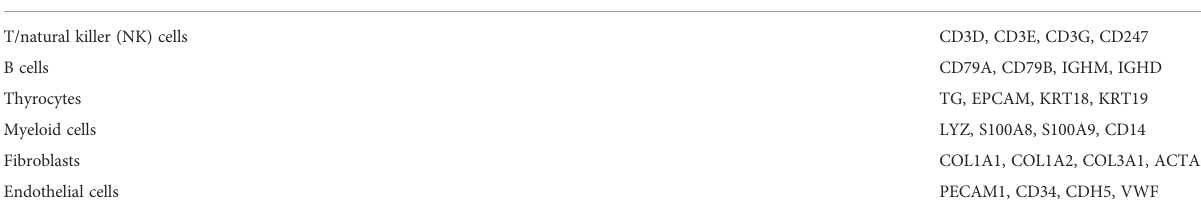
TABLE 1 Six cell subgroups and corresponding canonical